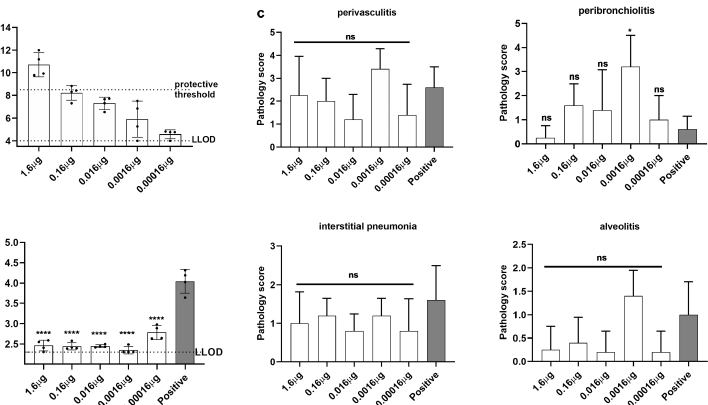
Figure 5. Alum-adjuvanted opti-FI-RSV at a suboptimal dose induces ERD in cotton rats. Female cotton rats (n = 4 per group) were injected intramuscularly with opti-FI-RSV in a prime-boost regimen at week 0 and week 3. Animals were challenged with the RSV A2 strain intranasally at a titer of 1 × 10 6 PFU on day 49. Positive refers to cotton rats that were inoculated intramuscularly with an equal volume of DMEM(mock treatment) ( a ) Serum neutralizing antibody titers were measured using RSV A2 as described in the Materials and Methods. ( b ) RSV virus titers were determined in the right lung homogenate of cotton rats at day 5 after challenge as determined by PFU. ( c ) Left lungs were harvested at day 5 after challenge, and histopathology scoring was performed. Representative H&E staining images are shown in (Figure 6). ( a , b ) The symbols indicate individual rats, the bars/lines indicate the geometric mean ± geometric SD, and the dotted lines indicate the lower limit of detection and the protective threshold. ( c ) The bars/lines indicate the mean ± SD. ( b ) The data were analyzed by one-way ANOVA followed by Tukey’s multiple comparisons post hoc test and ( c ) the data were analyzed by Kruskal-Wallis test (nonparametric) to analyze the differences between vaccination groups. The p values are shown by asterisks (ns = not significant; * p < 0.05; **** p < 0.00001).